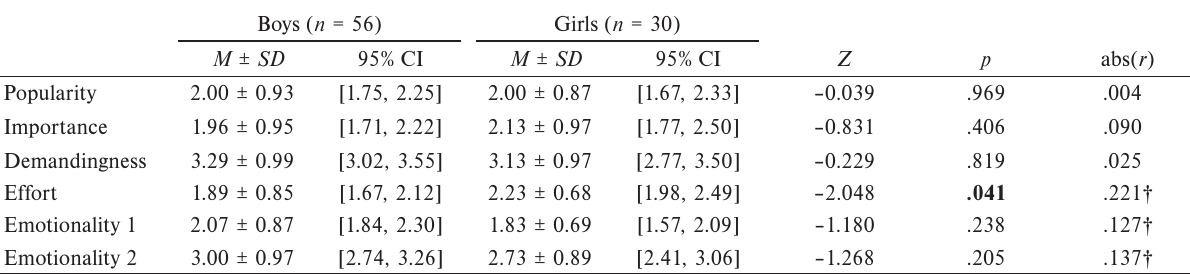
Intergroup comparison of mean values of attitudes towards physical education by